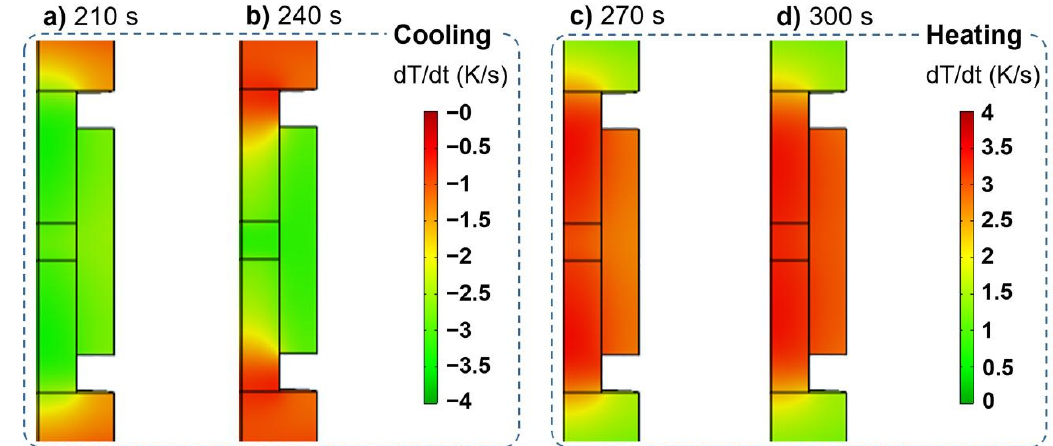
Figure 6. Typical heating rate fields from the punch-controlled PID regulation of continuous temperature profile at different times: ( a ) 210 s; ( b ) 240 s; ( c ) 270 s; ( d ) 300 s.